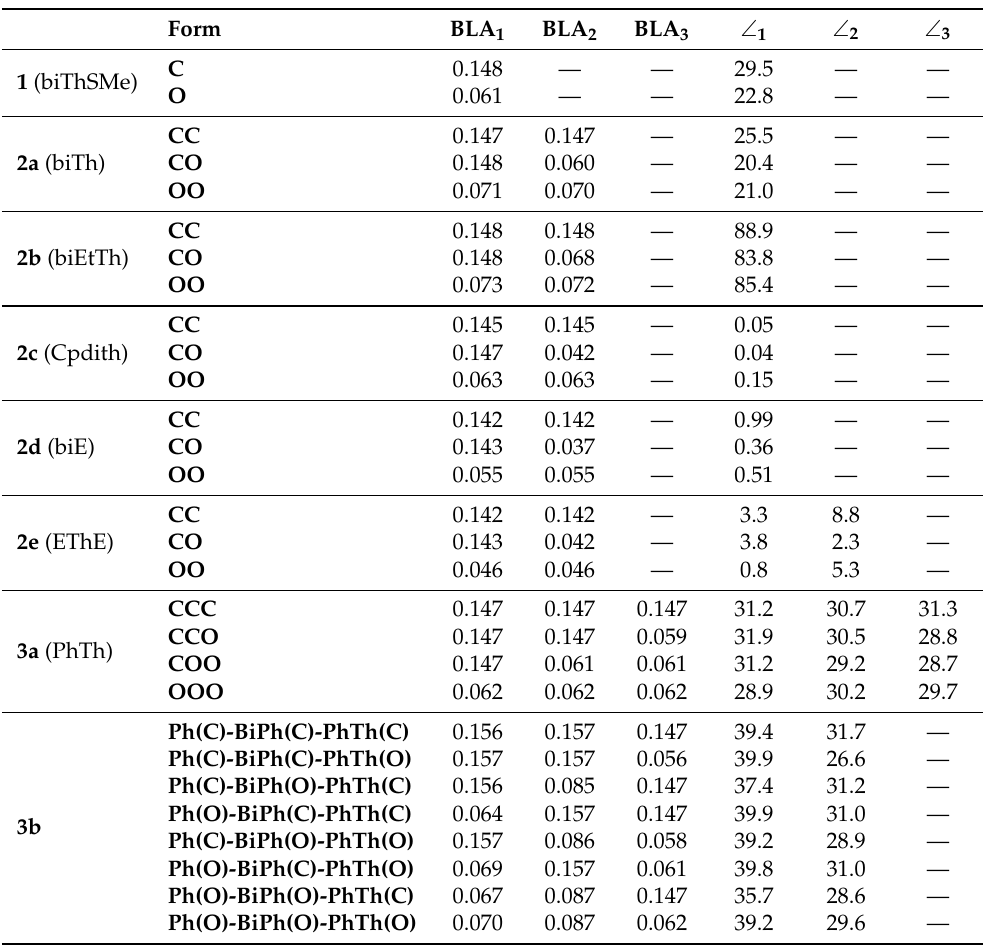
Table 1. BLA values (Å) and out-of-plane angles ( ∠ , °, computed from the dihedral angles θ ) of the different forms of the compounds, as defined in Figure 3 and evaluated at the ω B97X-D/6-311- G(d)/IEF-PCM (acetonitrile) level of theory. These are averaged values using the MB populations at 298.15K as calculated at the ω B97X-D/6-311G(d)/IEF-PCM (acetonitrile) level of theory. Form BLA 1 BLA 2